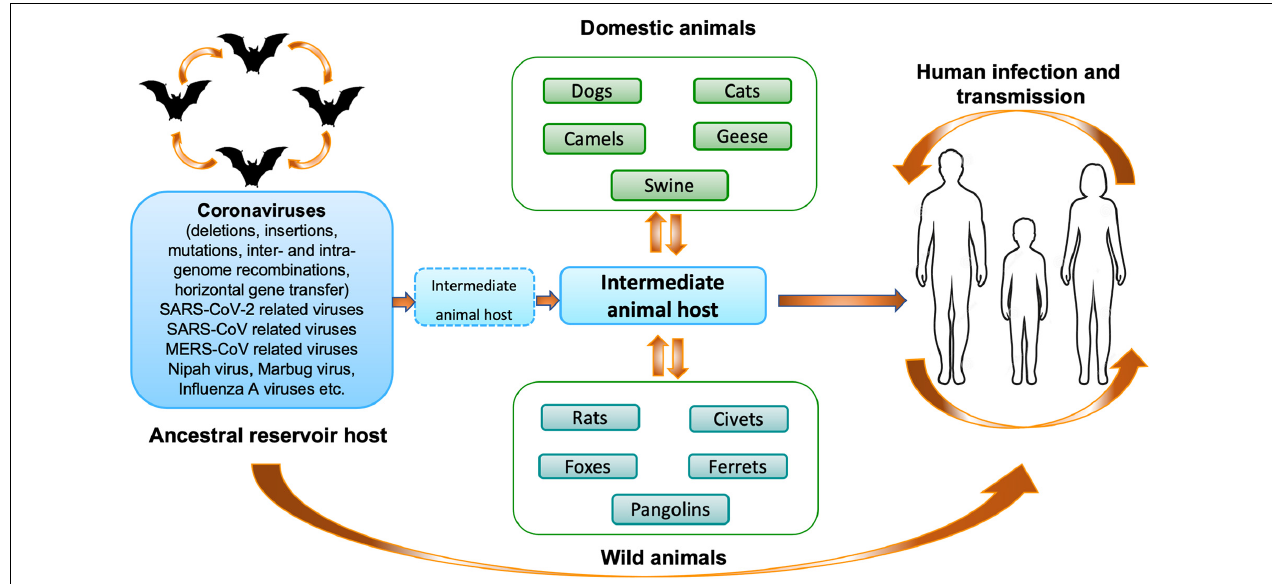
FIGURE 2 | Origin and transmission of coronaviruses. Schematic representation of the origin and transmission of coronaviruses, as well as SARS-CoV-2, between hosts and humans (Mahtarin et al.,